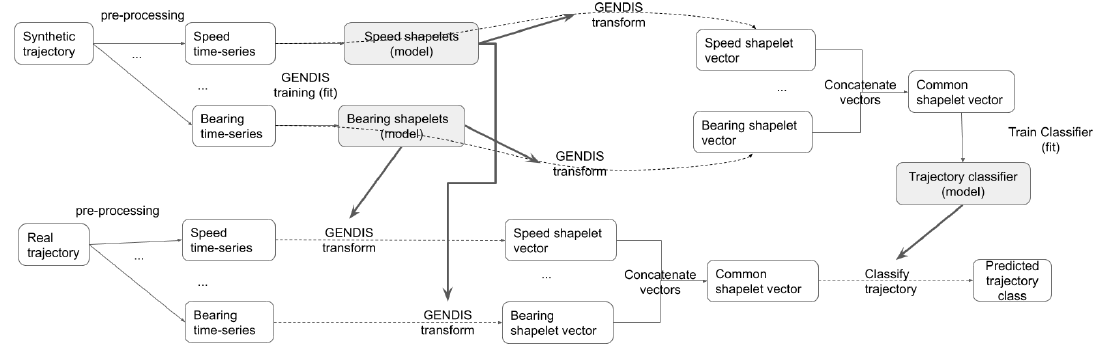
Figure 3. Training the classifier with multiple time-series data from the same